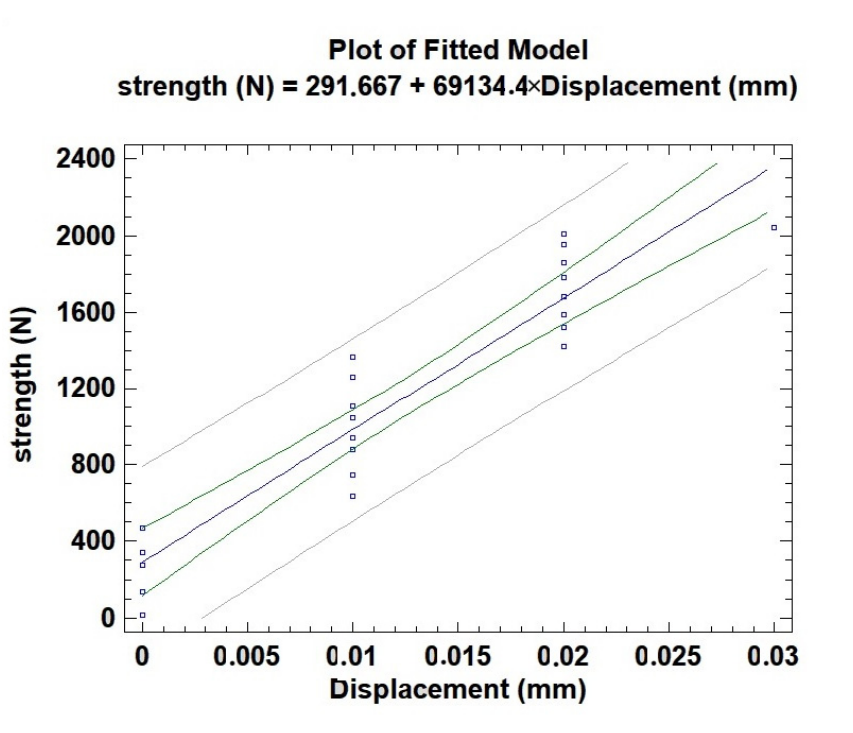
Figure 9. Graph of the adjusted model Test 1. Composite material 50% fly ash (D: 20 mm/E: 70 mm).